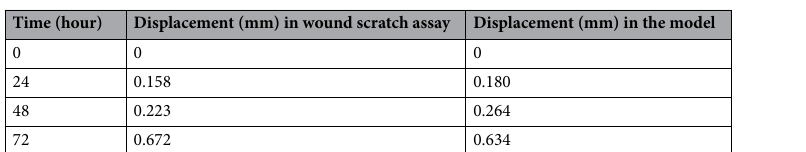
Figure 8. Simulation results of multiscale model of cancer cells movement during 10 time steps. Cancer cells and CAFs are depicted by red and black dots, respectively. Primary arrangement of cancer cells is randomly selected and it is shown in k = 0. After 10 repetitions, not only has the number of cells increased, but also they have been moved in space and left the primary tumor. The x–y-z axes have been scaled in centimeters.